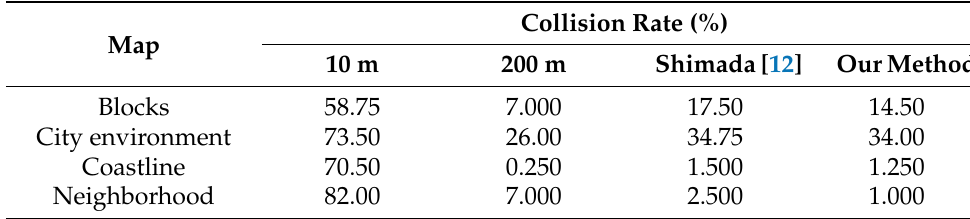
Table 6. Comparison of collision rate.